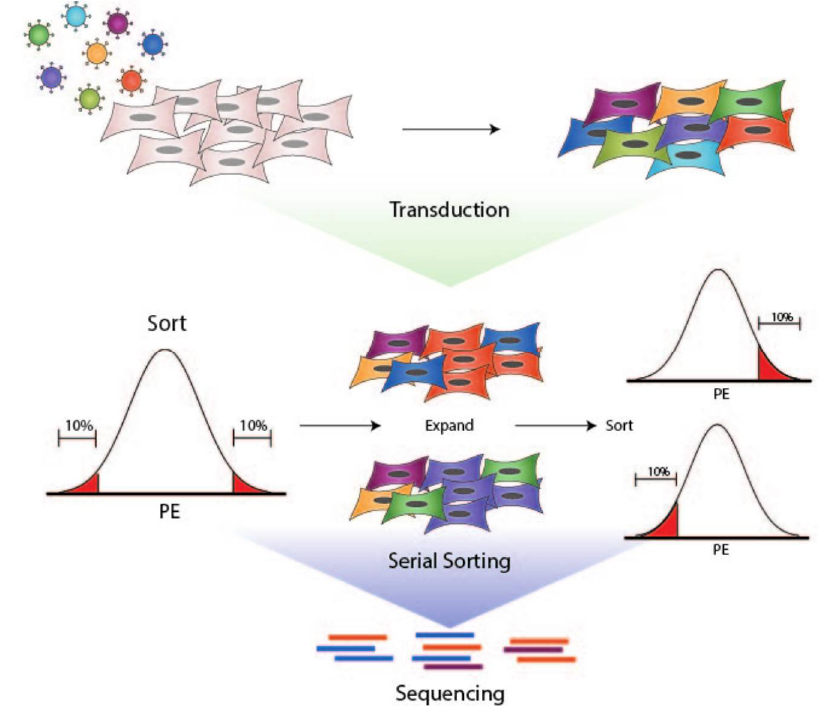
Figure 1. Workflow for generation of UM-SCC-49-GeCKO pool, cell sorting, and sequencing of final populations. 1. UM-SCC-49 was transduced with a lentiviral pooled sgRNA library (GeCKO v2). 2. Live cells were selected based on PDL1 expression using a PE-conjugated antibody directed against PDL1. PE fluorescence distribution was plotted on a histogram. The fractions of cells with the highest and lowest PE fluorescence (10% each) were expanded separately in culture and re-sorted to enhance respective phenotypes. 3. DNA was harvested from final populations for next-generation sequencing of sgRNA barcodes.